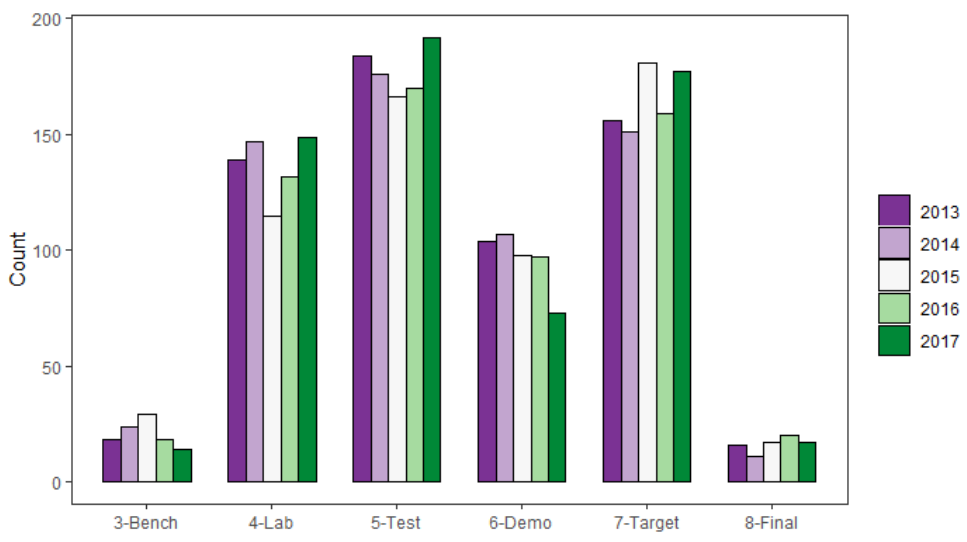
Figure 4. Deployment distribution between TRL in each of the sample years.